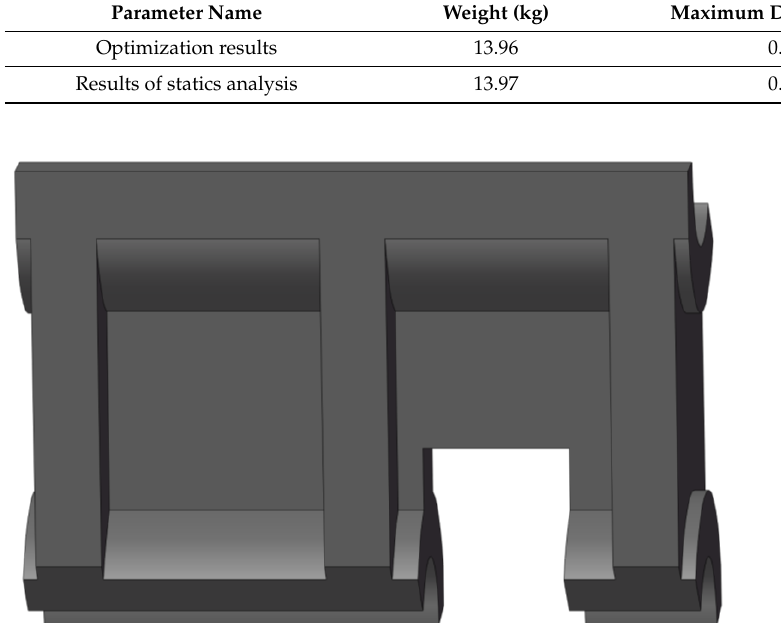
Figure 28. Model after optimization.